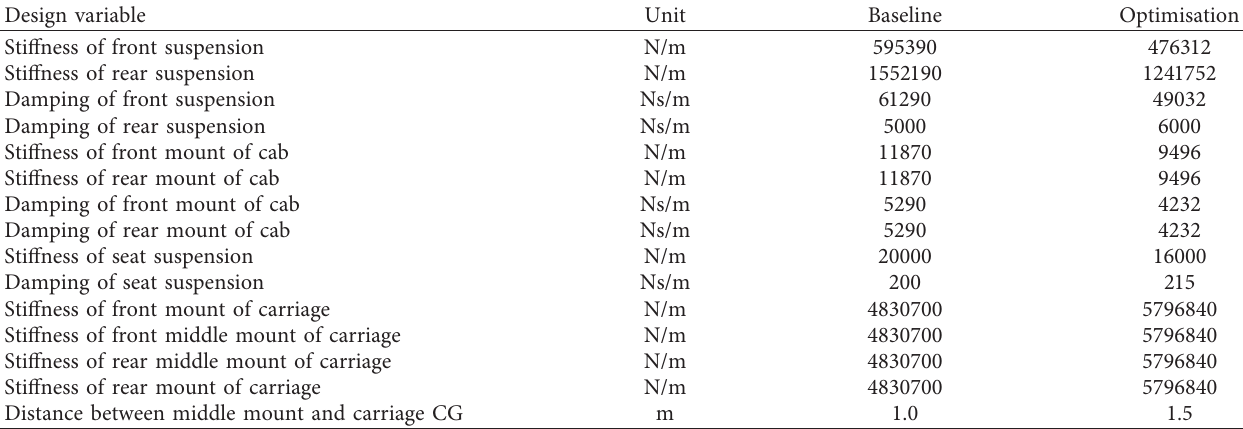
Table 2: Optimal results of design variables.